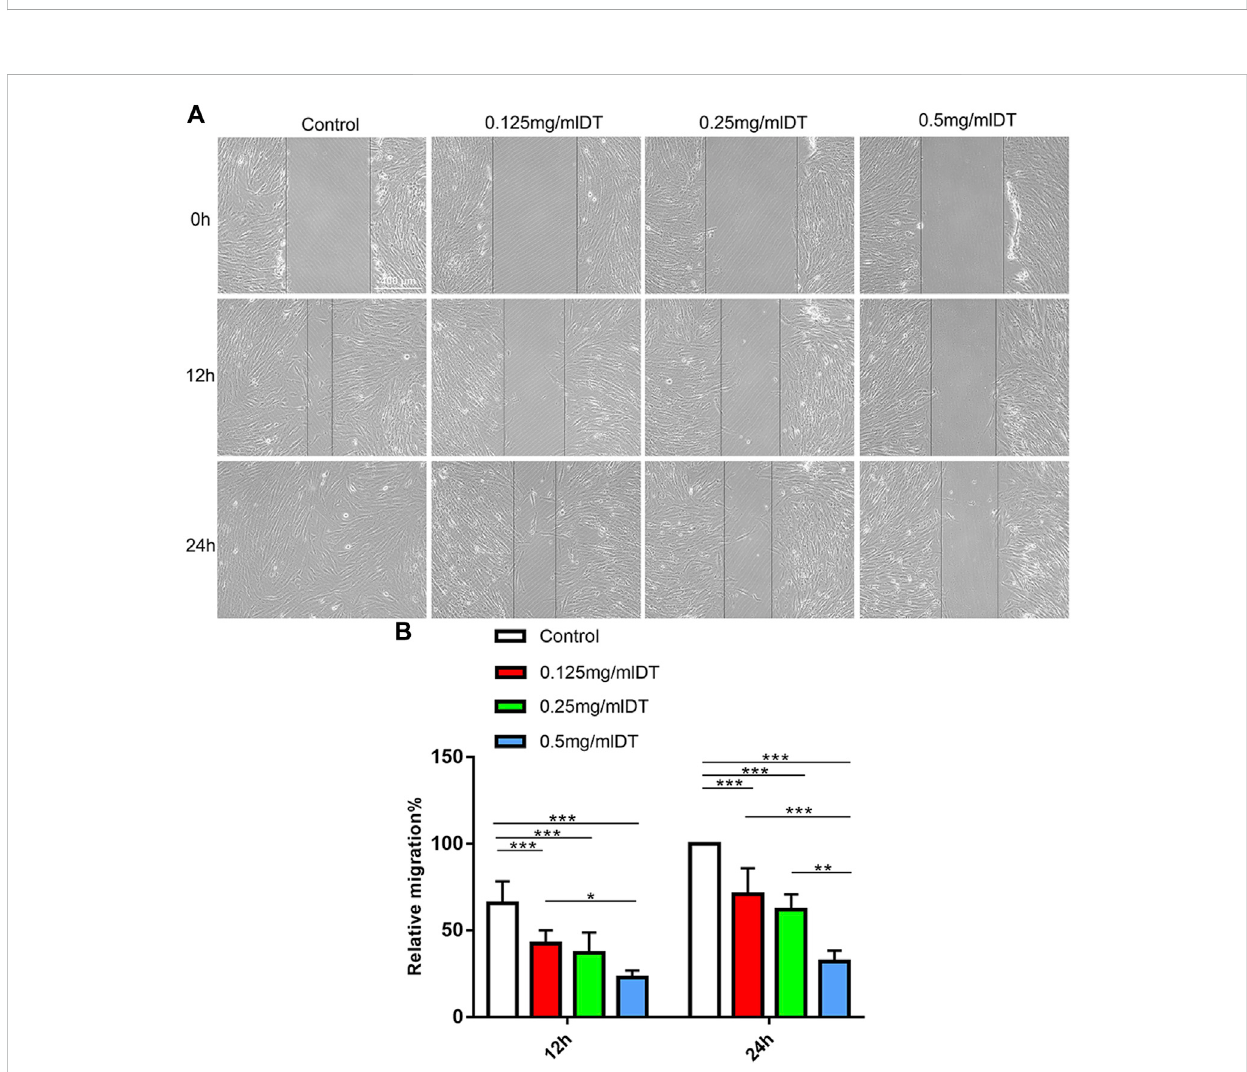
FIGURE 4 Cell migration. (A) Wound Healing Assay was used to analyze the ability of cell migration. (B) Quantitative analysis of relative migration. Data were expressed as means ± SD, *p < 0.05, **p < 0.01, ***p < 0.001.